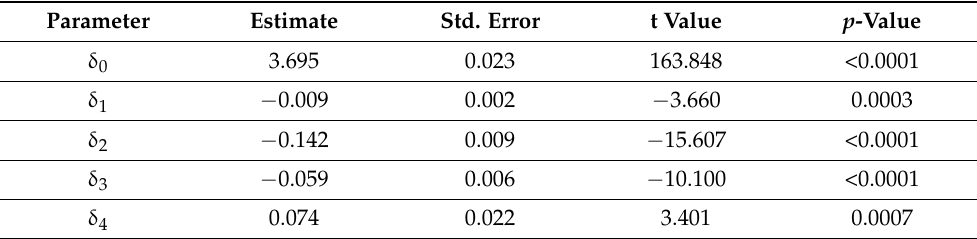
Table A4. Summary statistics of the linear model for detailed measurements of modulus of